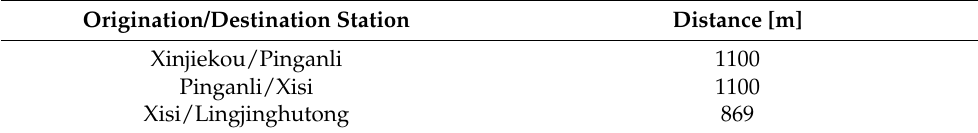
Table 5. Distance between